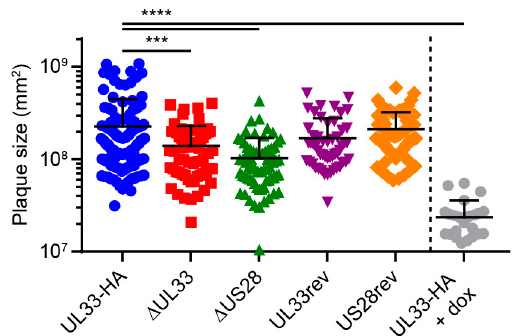
Figure 2. UL33 and US28 contribute to cell-to-cell infection in fibroblasts. Surface area of individual plaques formed by the HCMV Merlin recombinants: HFFF TR cells were infected at 0.001 multiplicity of infection (MOI) and maintained for 14 days under a semi-solid Avicel overlay to prevent cell-free virus spread. Merlin-UL33-HA-infected cells were stimulated with 1 µ g / mL doxycycline (dox) to induce expression of RL13 and UL128L. Results from 3 individual experiments were pooled, and error bars show mean and SD. ***, p < 0.001; ****, p < 0.0001 using Dunnett’s corrected one-way